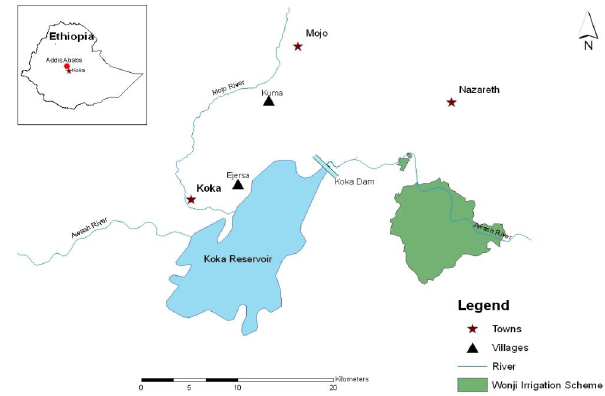
Fig. 1. Map of the Koka area in the middle course of the Ethiopian Rift Valley (Triangles show the study villages). (Courtesy: International Water Management Institute (IWMI), Addis Ababa, Ethiopia).